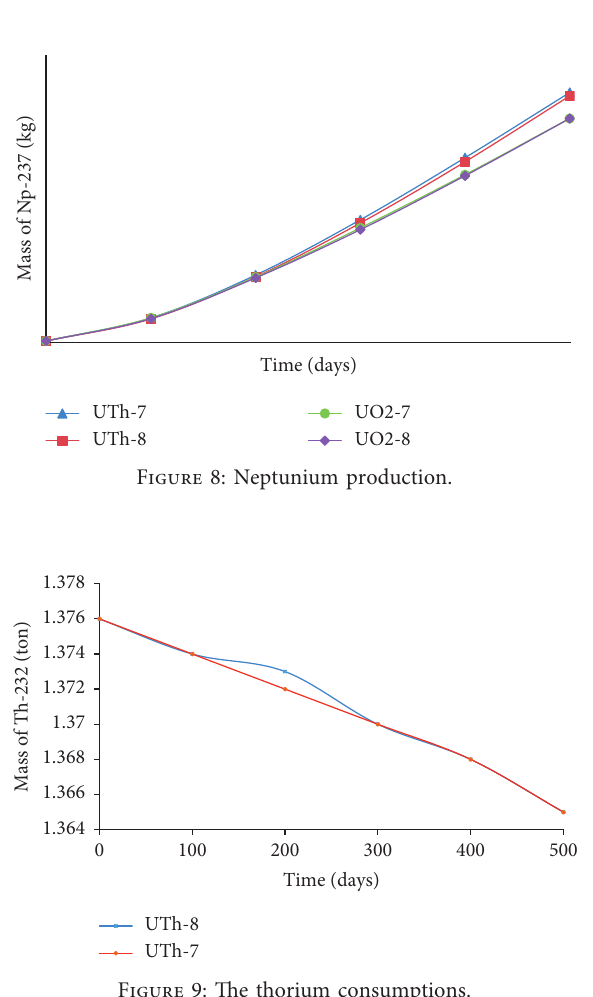
Figure 9: The thorium